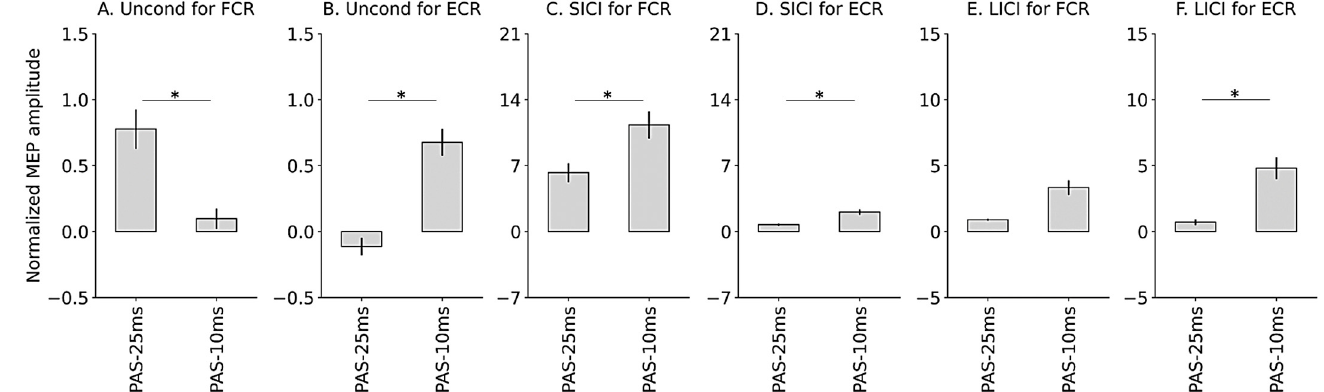
Figure 4. Bar graphs of NA values for the unconditioned MEP for FCR ( A ) and ECR ( B ) muscles, SICI for FCR ( C ) and ECR ( D ) muscles, and LICI for FCR ( E ) and ECR ( F ) after PAS-25 ms and PAS-10 ms at the group level. The unconditioned MEP for FCR for PAS-25 ms were larger than those for PAS-10 ms, whereas the unconditioned MEP for ECR for PAS-25 ms were smaller than those for PAS-10 ms. The SICI and LICI for both FCR and ECT for PAS-25 ms were smaller than those for